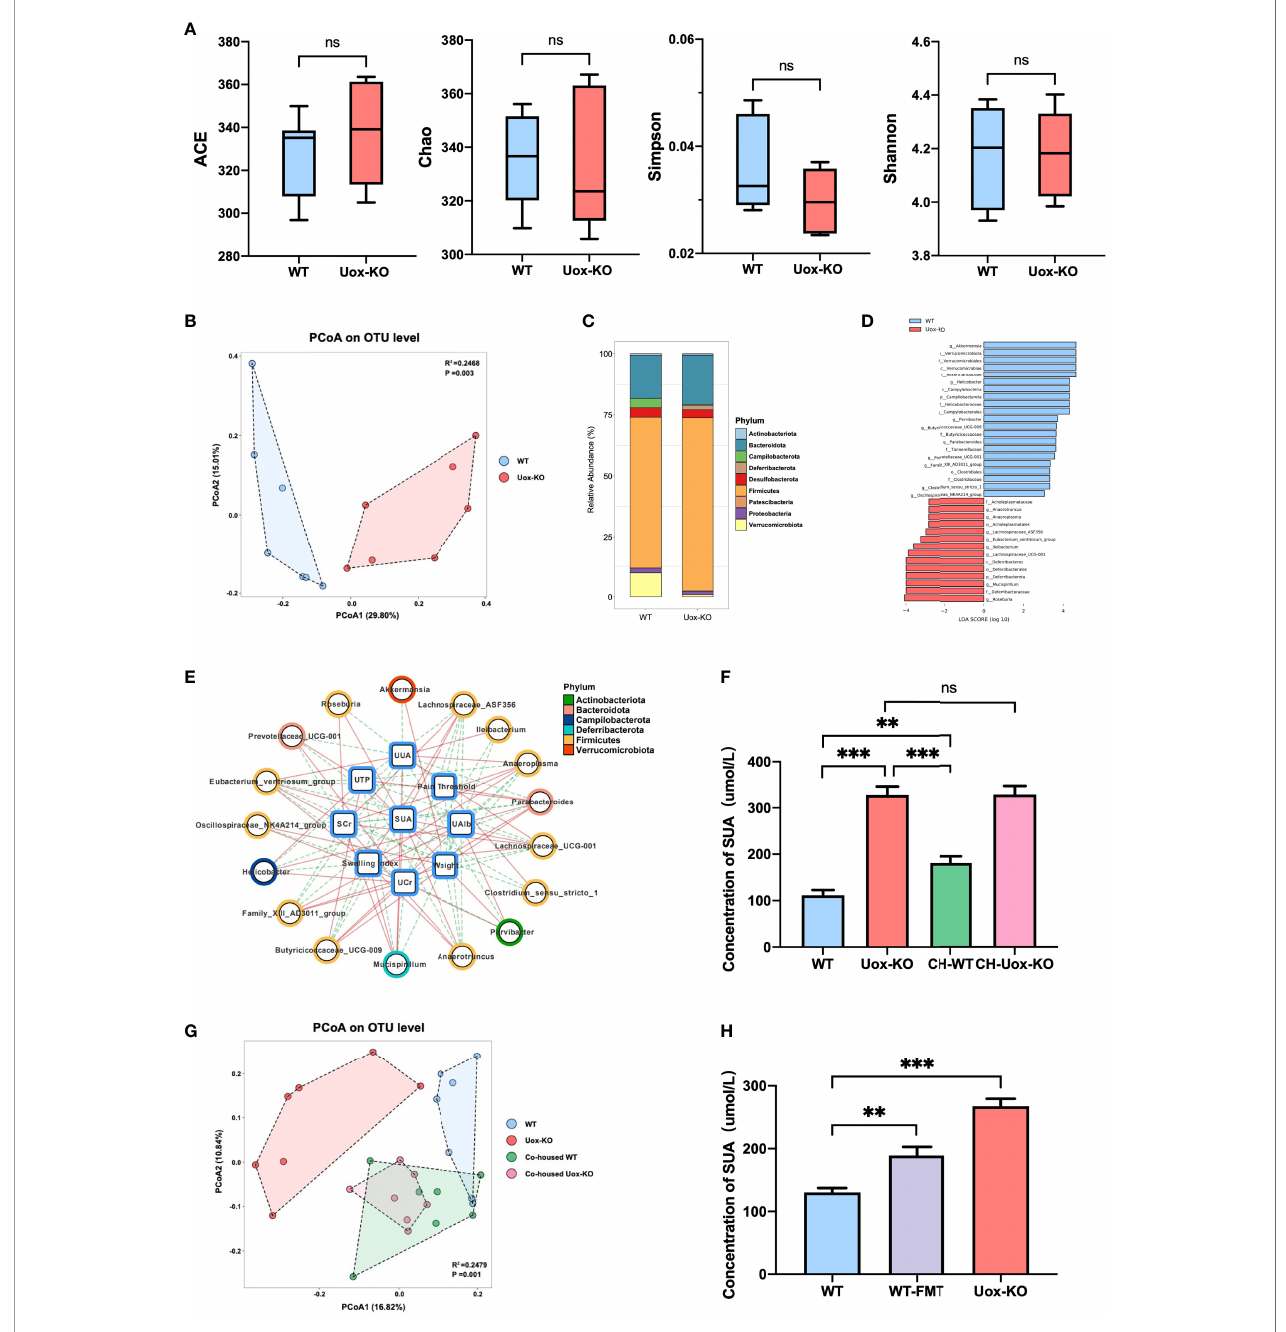
FIGURE 1 | Changes in the gut microbiota composition with HUA and gout. (A) Species richness indices (ACE & Chao) and species diversity indices (Shannon & Simpson) were used to evaluate alpha diversity. (B) Principal coordinate analysis plot of beta diversity as measured by Bray-Curtis distance ( p =0.003). (C) Mean relative abundance of taxa at phylum level. Legend lists only the top taxa. (D) A histogram of the LDA scores was computed for features that showed differential abundance between WT and Uox -KO mice. Only taxons with LDA scores >2 and p < 0.05 are represented. (E) The correlation networks among disease indices and differential microorganisms. The line colors indicate positive correlation (red implementation) or negative correlation (green dashed line) ( p <0.05, r>0.5 or r<- 0.5). (F) SUA concentration of co-housed mice. (G) PCoA analysis of co-housed mice ( p =0.001). Co-housed WT had the similar composition of the gut microbiota with Uox- KO mice. (H) SUA concentration of WT-FMT mice. Values are expressed as mean ± SEM. “ ns ” represents not signi fi cant; ** p < 0.01; *** p <